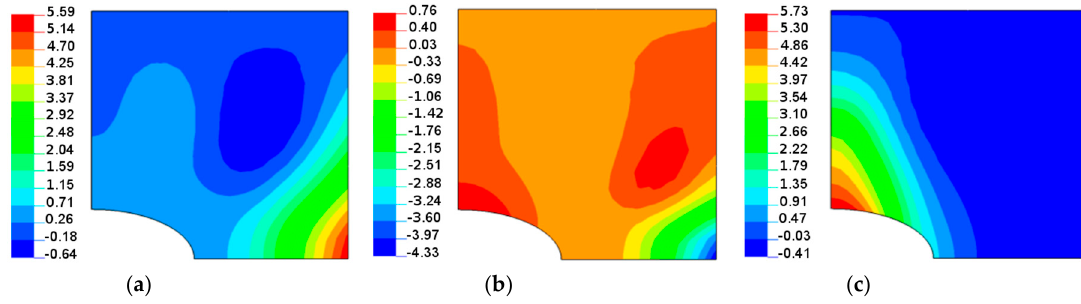
Figure 15. Buckling modes (normal deflections) for the square plate with the elliptical horizontal hole 2 b / L x = 0.4, b / a = 2: ( a ) isotropy E 1 / E 2 = 1; ( b ) E 1 / E 2 = 2 θ = 14°; ( c ) E 1 / E 2 = 2 θ = 30°.